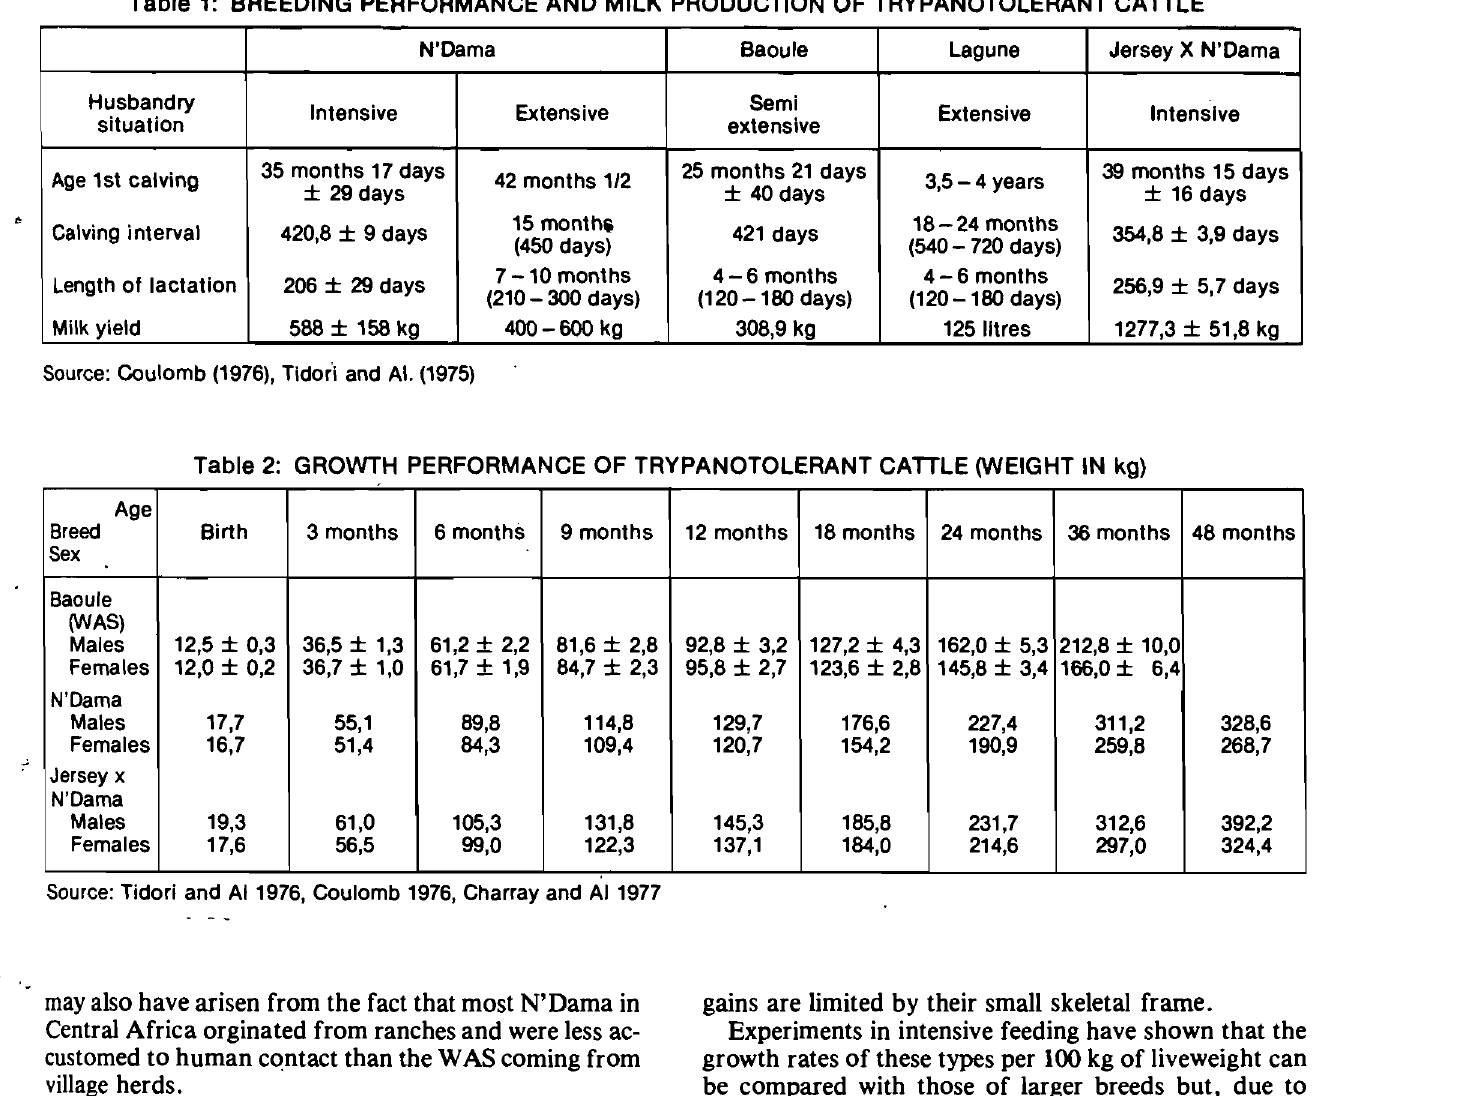
Table 1: BREEDING PERFORMANCE AND MILK PRODUCTION OF TRYPANOTOLERANT CATILE